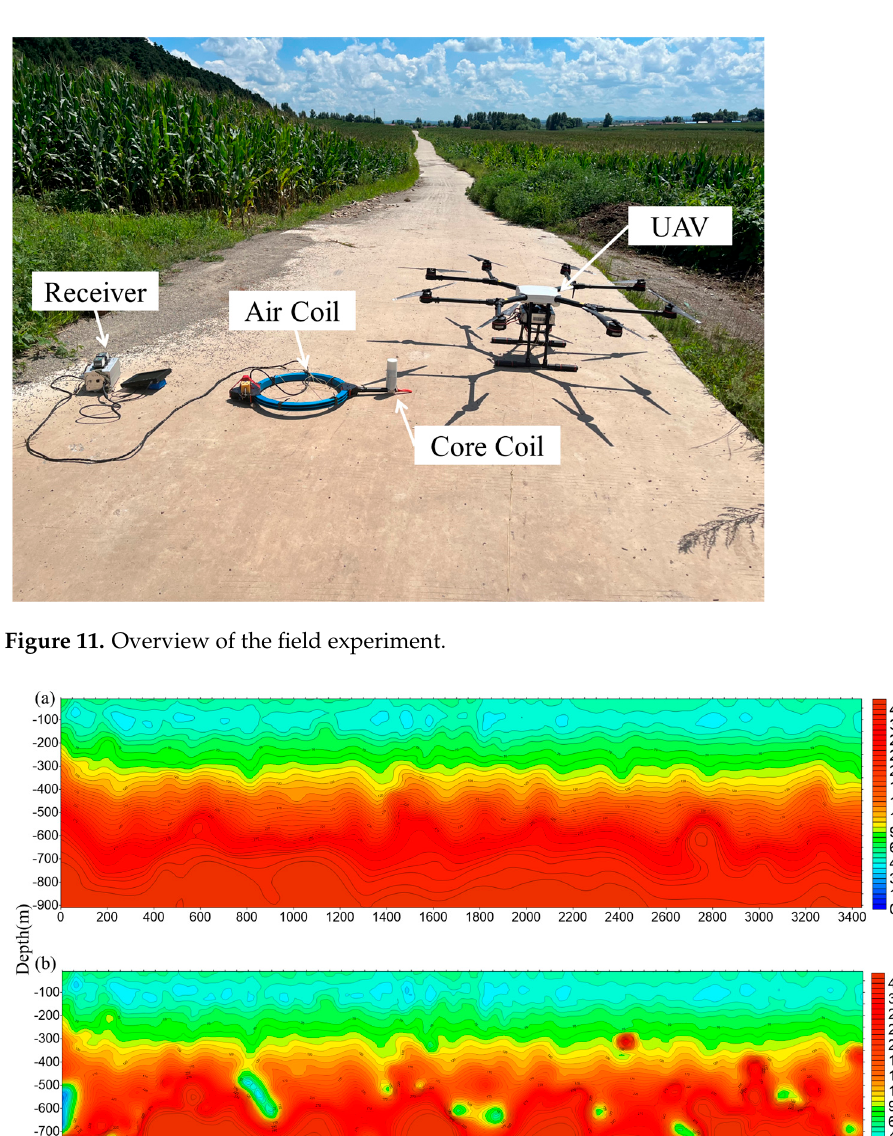
9 of 11 Figure 10. Location of the fi eld experiment. To verify the e ff ectiveness of the core coil at low frequencies, we measure the core coil and the air coil as shown in Figure 11. The distance between the core coil (search coil magnetometer) and the axis of the air coil is set to 0.5 m to reduce the disturbance between them. The signals from the two di ff erent coils are received by the dual-channel receiver, and the transmi tt ing system transmits in the frequency range of 10 Hz–10 kHz with a transmi tt ing current of 30 A at the location shown in Figure 10. The electrical structure in